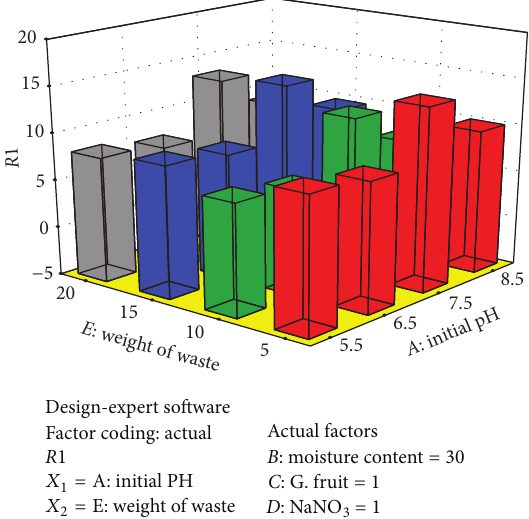
Figure 5: 3D surface plot showing the effect of initial pH and weight of waste on naringinase